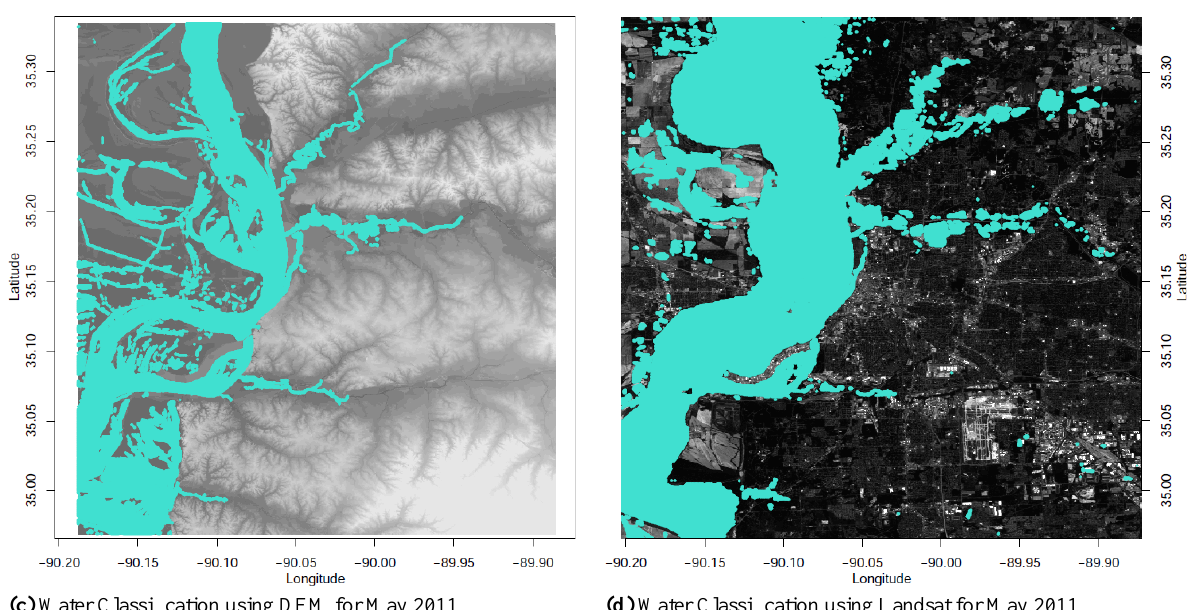
Fig. 5. Water pixel classification using the DEM ( a and c ) and Landsat ( b and d ) and for January (top) and May (bottom) data. The background ( b and d ) is from Landsat band